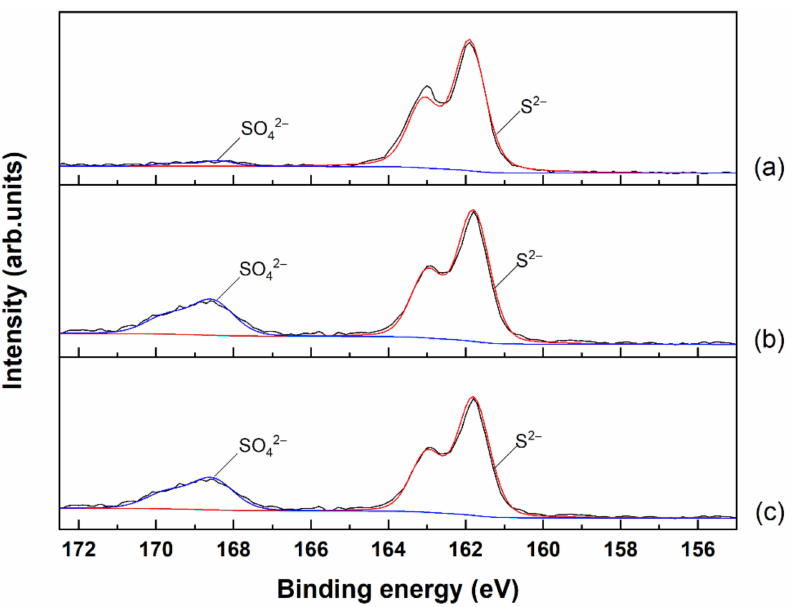
Figure 6. S 2p XPS spectra of MoS 2 samples prepared at ( a ) pH 4.5; ( b ) pH 7.0; and ( c ) pH 9.5. Typical S 2p peaks consist of S 2p3/2 and S 2p1/2 states with a peak area ratio of